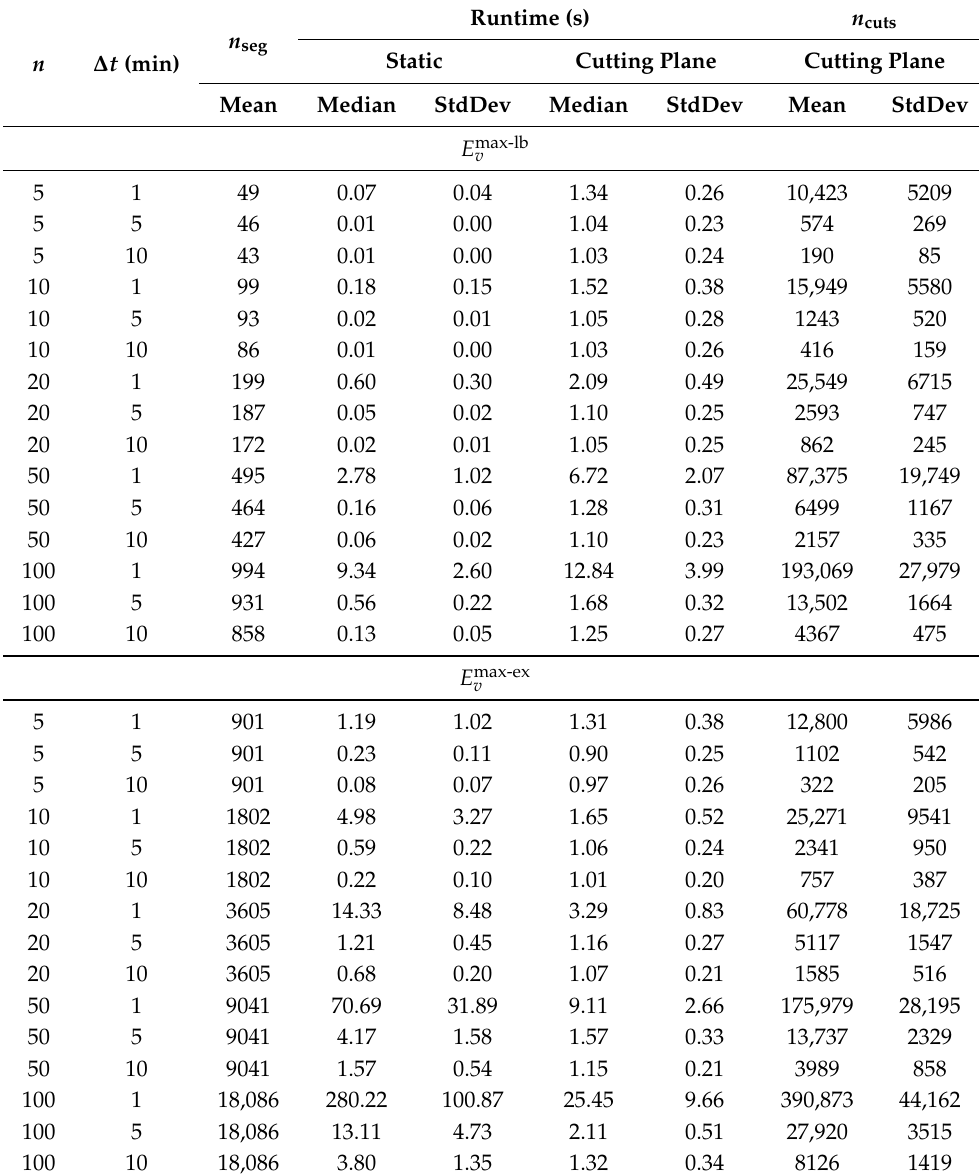
Table 2. EVS-SOC-LIN runtime comparison for concave maximum power functions and P gridmax = 25 n : solving the static MILP versus the cutting plane method.